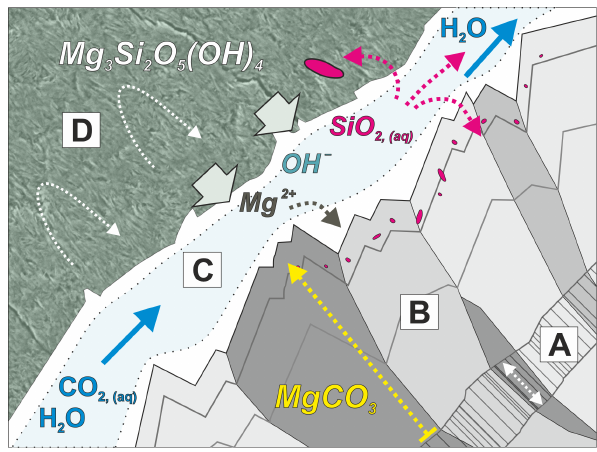
Figure 11. Conceptual sketch of magnesite vein growth by replace- ment of serpentine. Domain A: initial dilatant fracture with car- bonate infill, forming the median lines of zoned magnesite veins. B: magnesite vein growth rim formed by replacement. C: interface permeability at vein walls causes development of a fluid film with diffusion-dominated boundary layers (white) and a central advec- tive flow zone (light blue), which allows CO 2 influx and drives cou- pled serpentine dissolution and carbonate precipitation. The widths of boundary layers relative to the advective zone depend on fluid flow rate. The overall width of domain C is highly exaggerated for illustration purposes. D: nano-porous serpentine with predom- inantly diffusive solute transfer in matrix permeability. The obser- vations show that only small fractions of dissolved silica precipitate in situ (red), forming nano-inclusions in magnesite; most silica is leached and precipitates in other